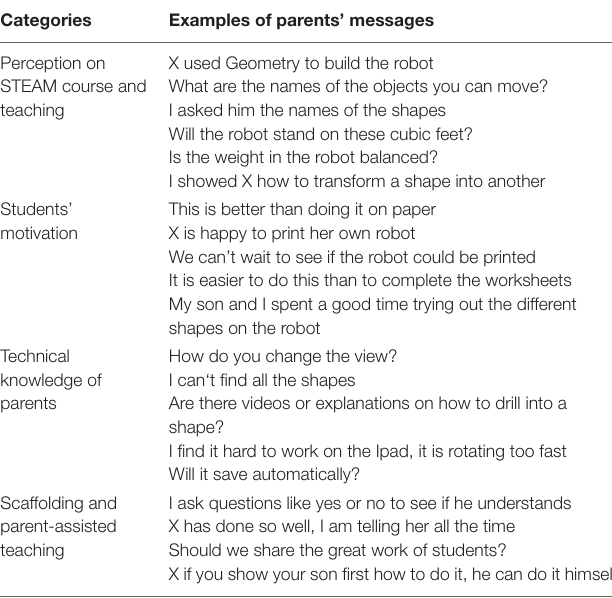
TABLE 2 | Examples of parents’ messages and